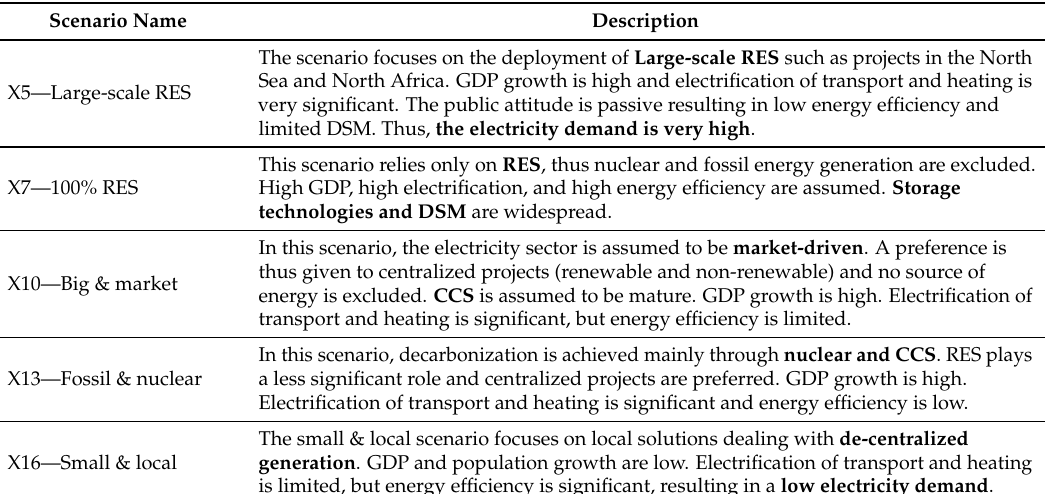
Table A1. Brief description of the e-Highway scenarios